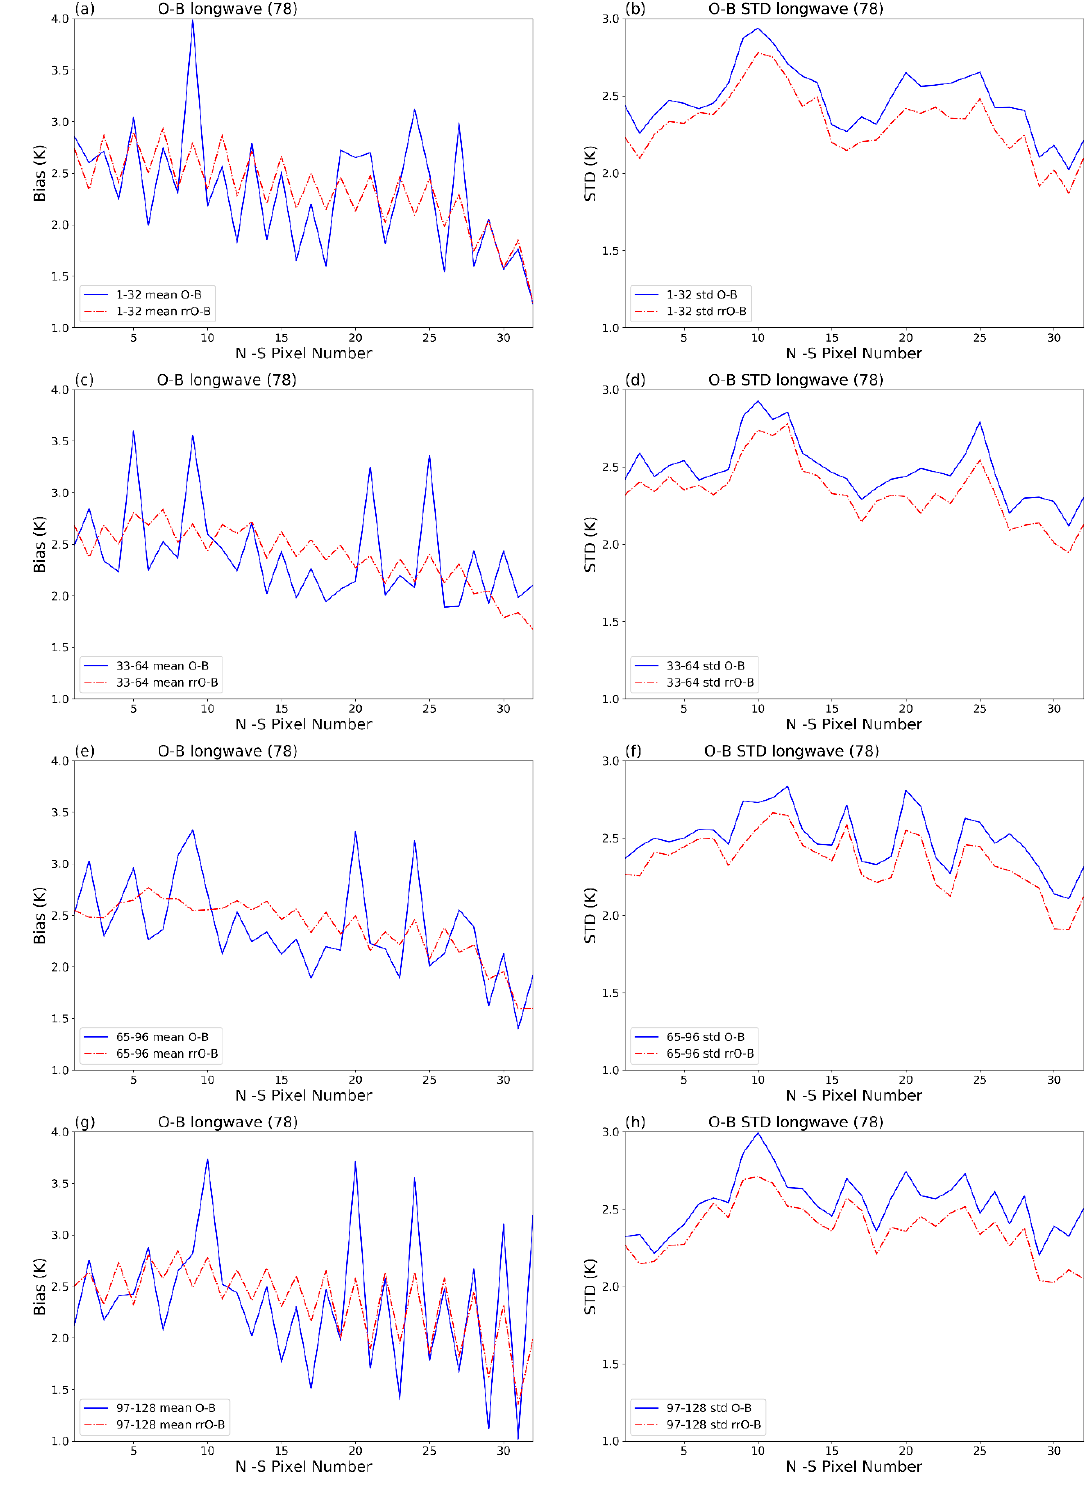
Figure 11. Background departures (O-B) and reconstructed background departures (rrO-B) of channel 78 in the ranges of ( a ) 1st to 32nd FOVs, ( c ) 33rd to 64th FOVs, ( e ) 65th to 96th FOVs, and ( g ) 97th to 128th FOVs; standard deviations of the background departures (O-B) and the reconstructed background departures (rrO-B) of channel 78 in the ranges of ( b ) 1st to 32nd FOVs, ( d ) 33rd to 64th FOVs, ( f ) 65th to 96th FOVs, and ( h ) 97th to 128th FOVs, respectively.